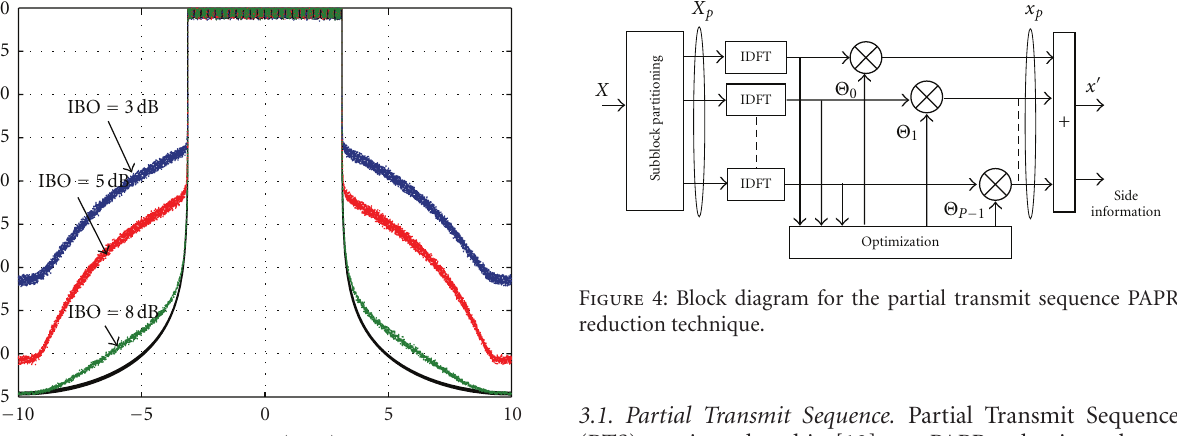
(PSD) of an OFDM signal with N = 256 subcarriers for di ff erent values of IBO. The spectral spreading is due to the nonlinear distortion.